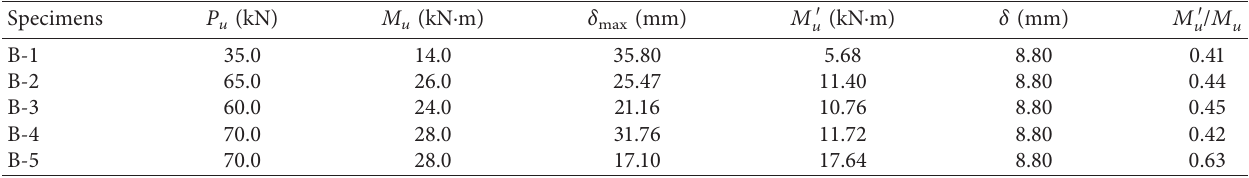
Table 4: Calculation results of specimens.